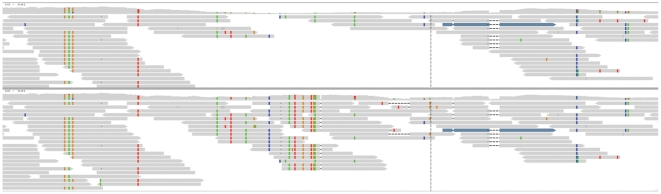
Improvement of the alignment for diverged regions using the PE-SW remap algorithm.IGV screenshot of the mapping of pooled sequence reads in a highly divergent region of D. melanogaster. The upper panel shows an alignment of the PE reads without the PE-SW remap and the lower panel shows the same region with the PE-SW remap.